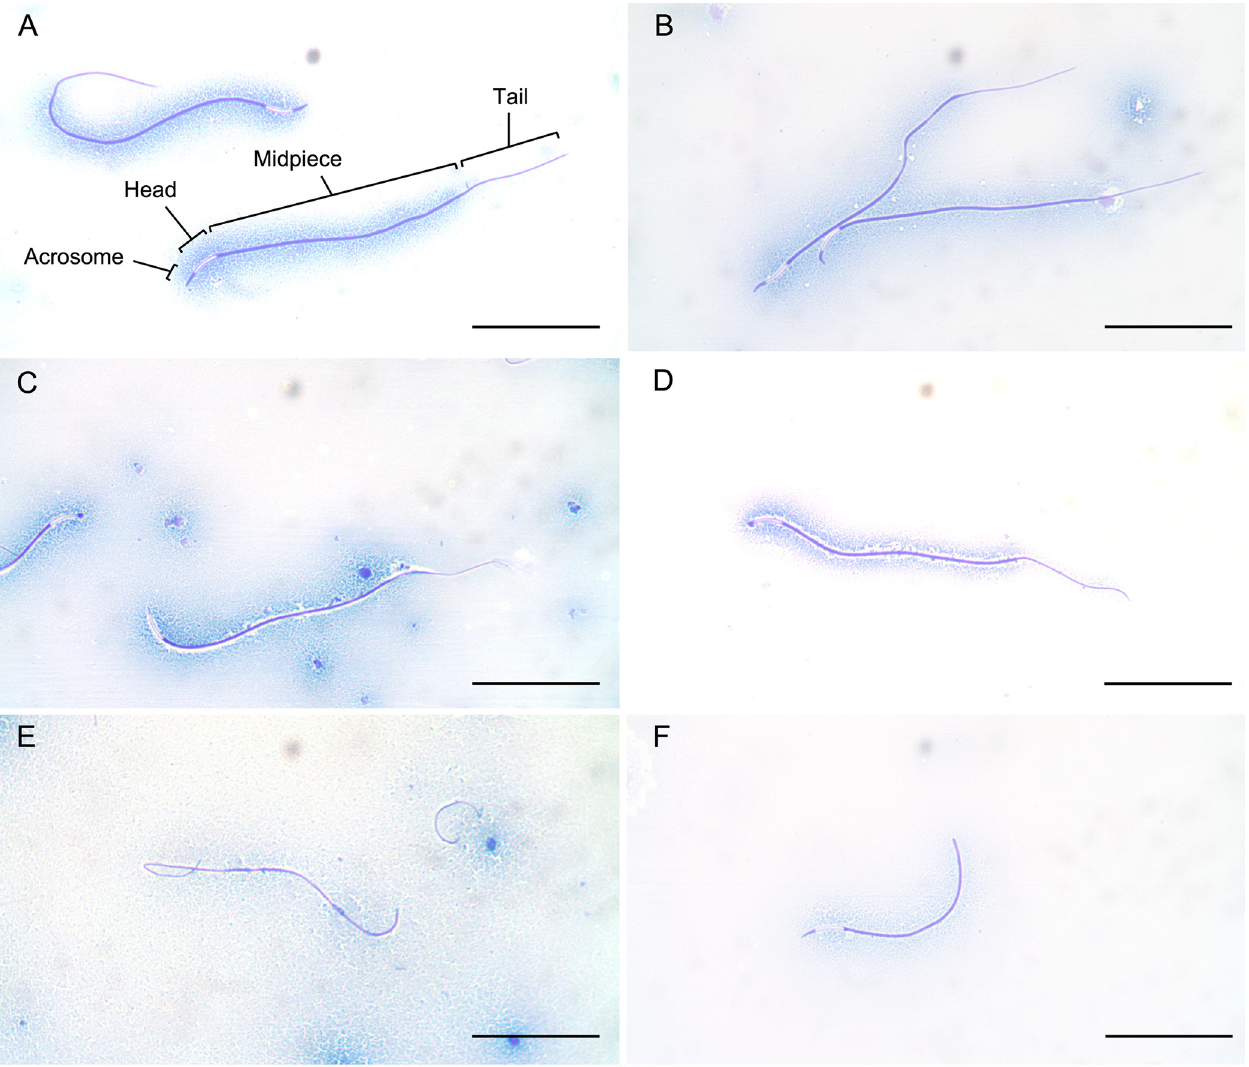
Fig 1. Microscopic images of sperm from the Louisiana pinesnake stained using a Pope’s stain on sperm with A) normal morphology and sperm demonstrating abnormalities including B) bent acrosome, C) missing acrosome, D) shortened acrosome, E) missing head, and F) missing tail. All images taken at 1000X magnification using an Olympus 0X40 phase-contrast microscope. Bars = 50 μ m.